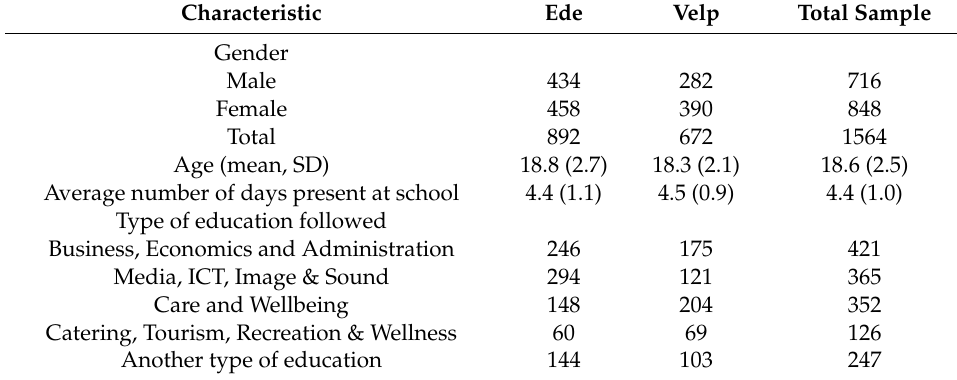
Table 3. Characteristics of survey participants across the two canteen